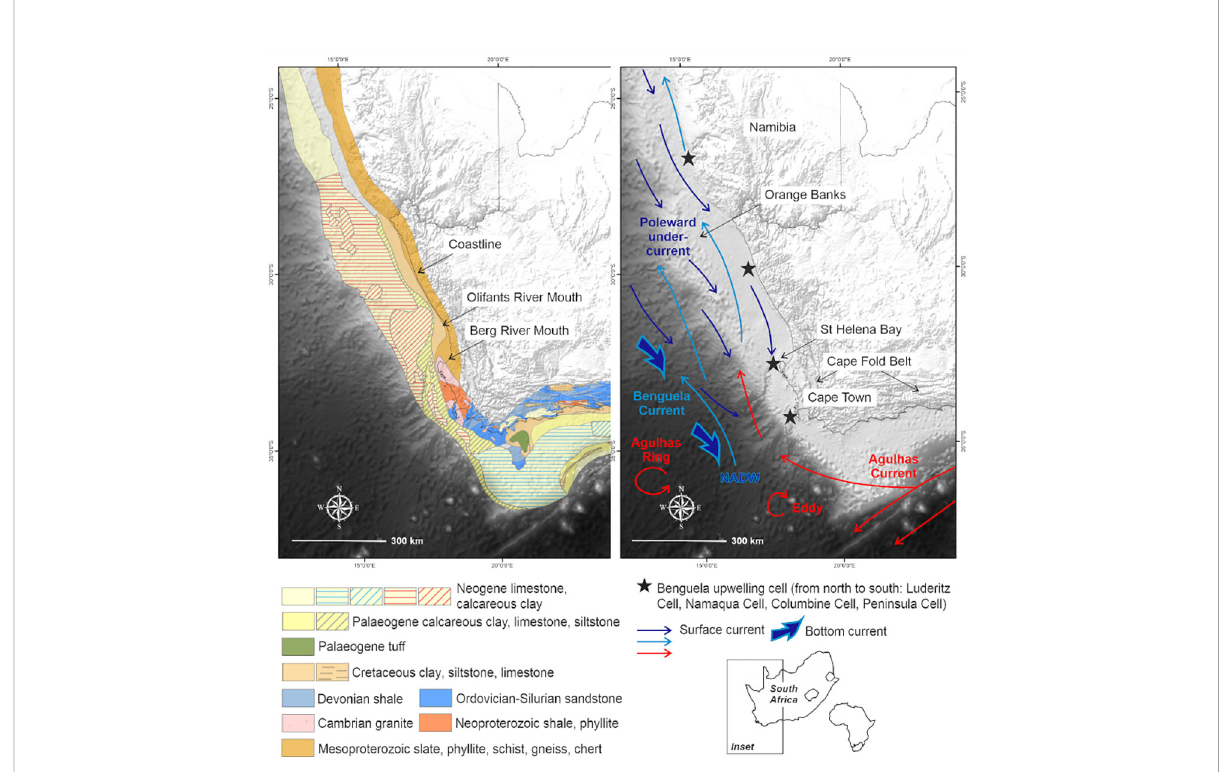
FIGURE 1 Map showing the South African western margin, in relation to the African continent, with underlying geology and circulation patterns of the Benguela